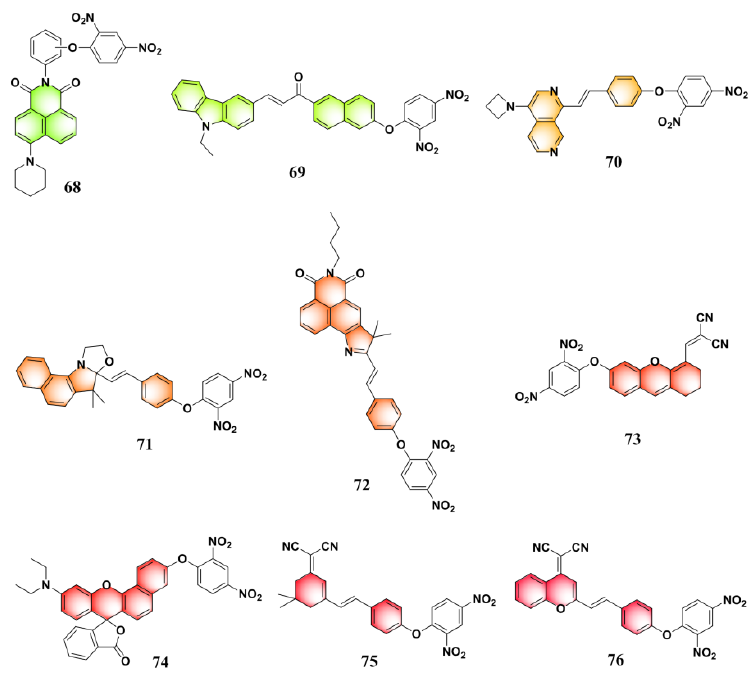
Figure 26. Structures of fluorescent PhSH probes ( 68 – 76 ).